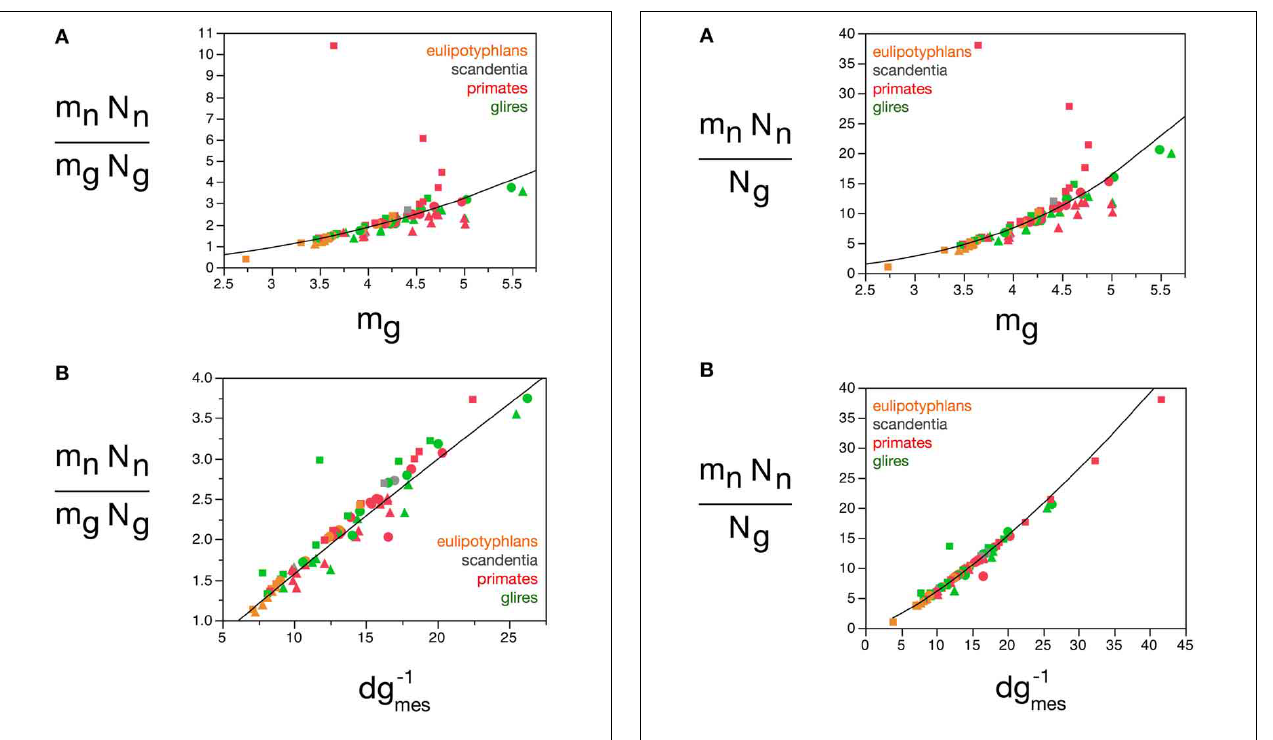
order that the species belongs to. Our finding indicates that either